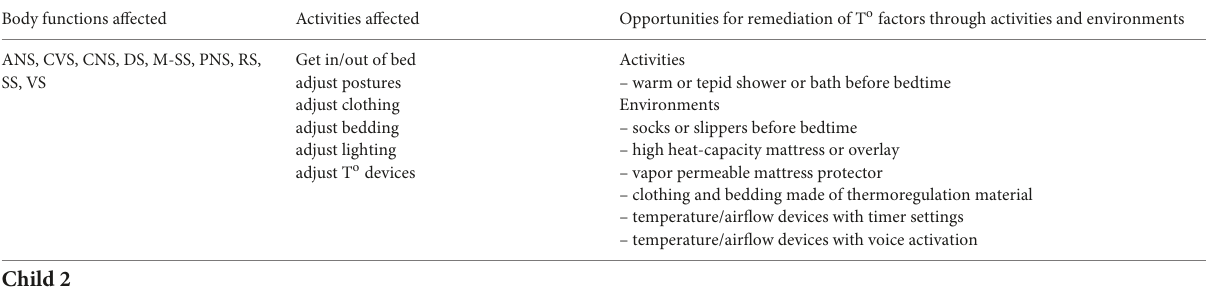
TABLE 1 Case descriptions of children with neuromotor, developmental and chronic health conditions, illustrating the interactions of body structures and function for thermoregulation and sleep, with opportunities for therapeutic modification to activities and environments. Child